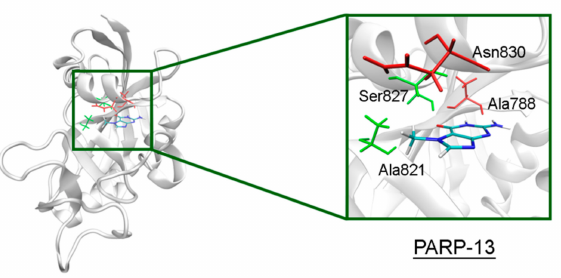
Figure 7. 7-MG position in the NA binding site of PARP-13 obtained using MD modeling. The conserved NA site residues are colored in green, and unique residues in red.